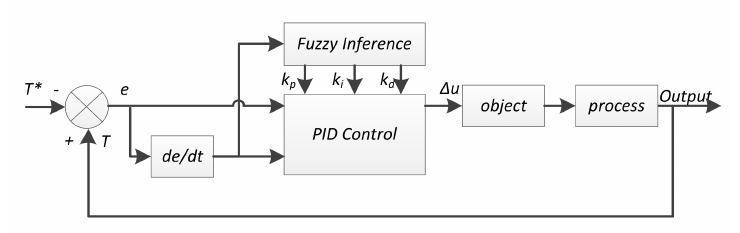
Figure 3. Fuzzy adaptive PID control system